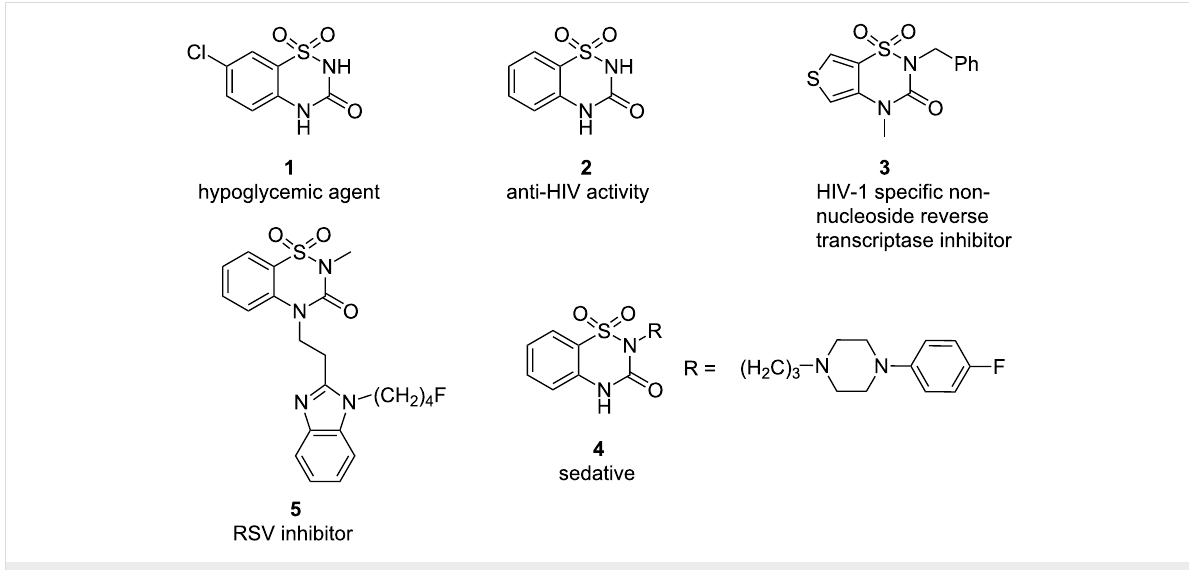
Figure 1: Biologically active 1,2,4-benzothiadiazine 1,1-dioxide derivatives.